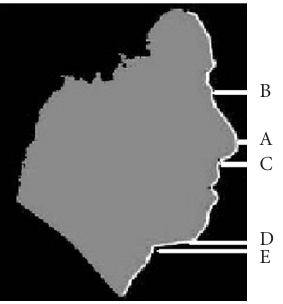
Figure 10: Typical profile function. Nose tip (A), nose bridge top (B), under-nose point (C), chin point (D), and neck top point (E) are